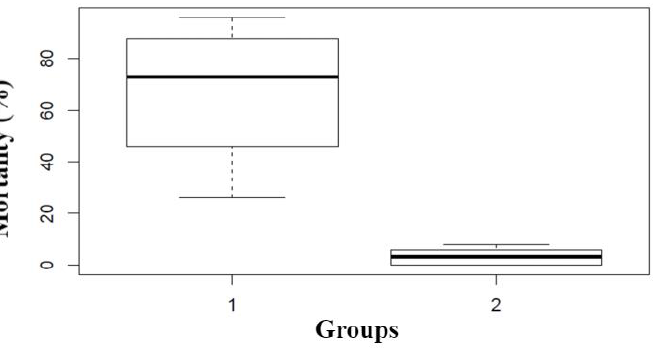
Figure 7. Variability in the fumigant action of the groups resulting from the cluster analysis